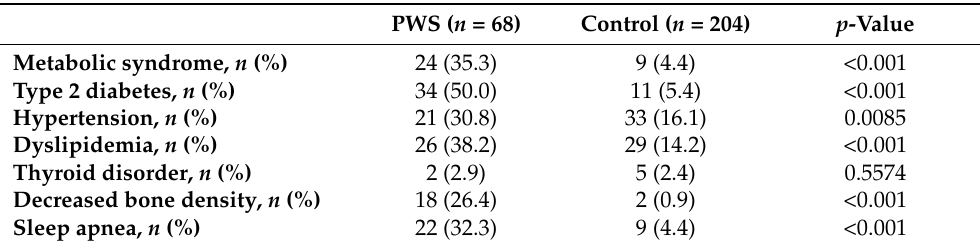
Table 2. Comparison of endocrine and metabolic illnesses in the Prader–Willi syndrome group and the age-, sex-, and BMI-matched healthy control